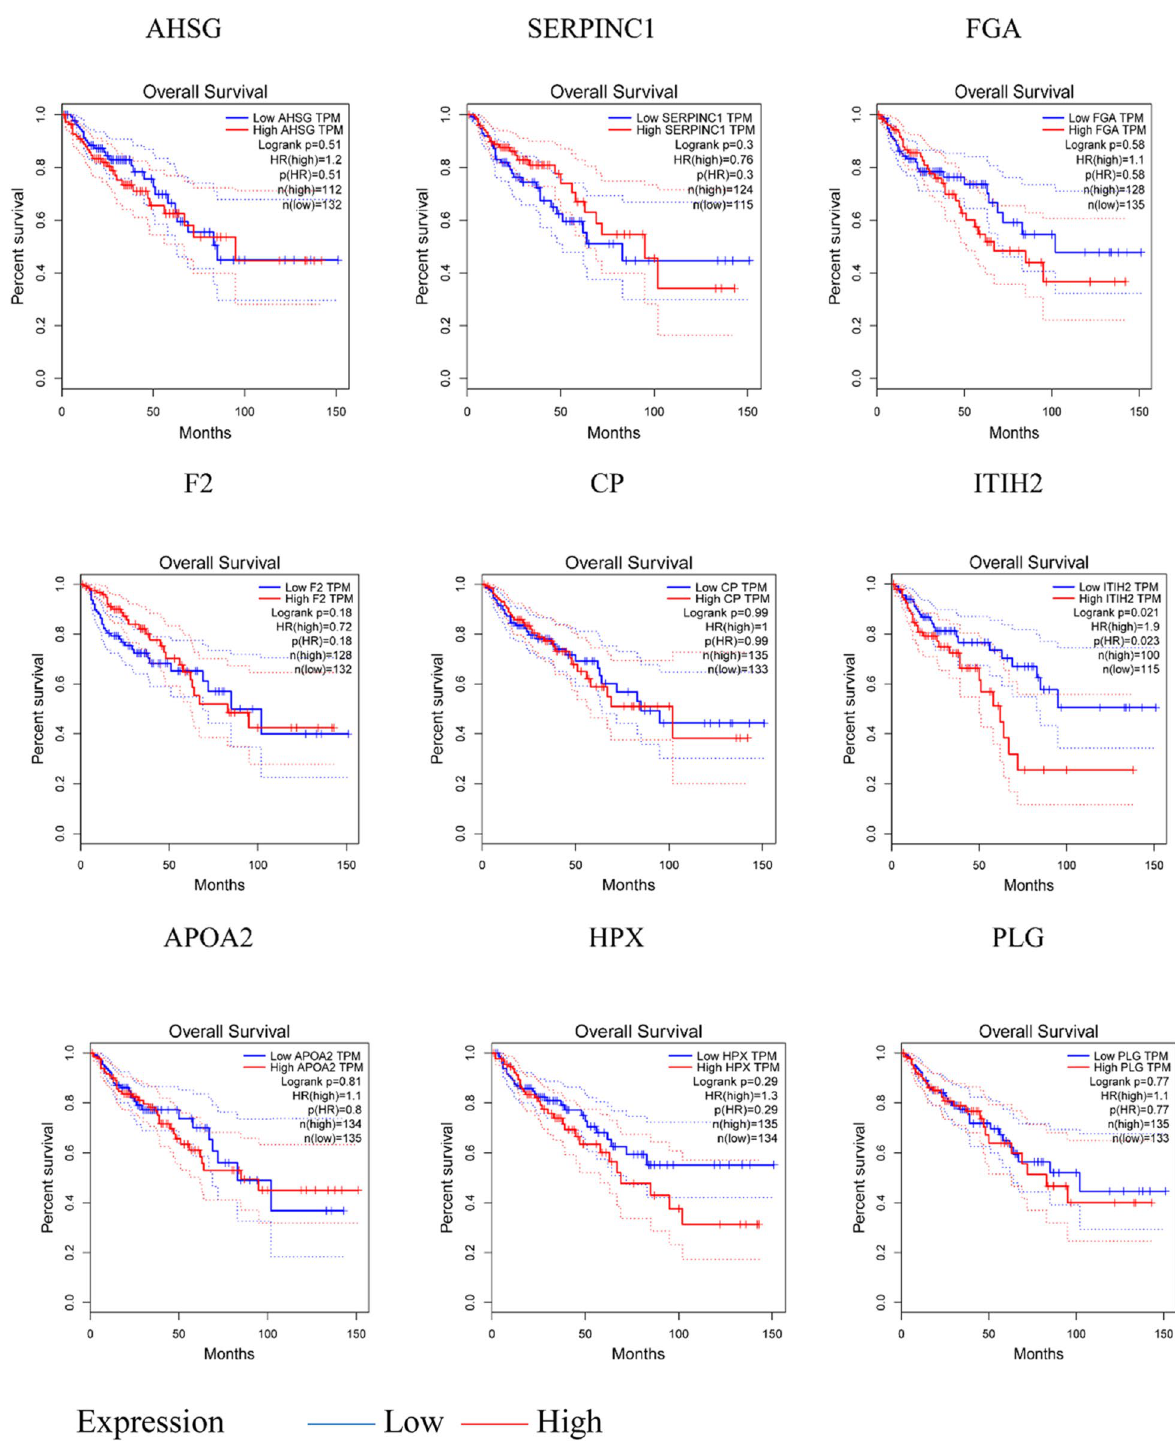
Figure 5. Kaplan–Meier survival analyses of DEGs between primary tumor tissues and metastasis tumor tissues. Over-expression of ITIH2 was associated with poor overall survival. See Table 4 for gene